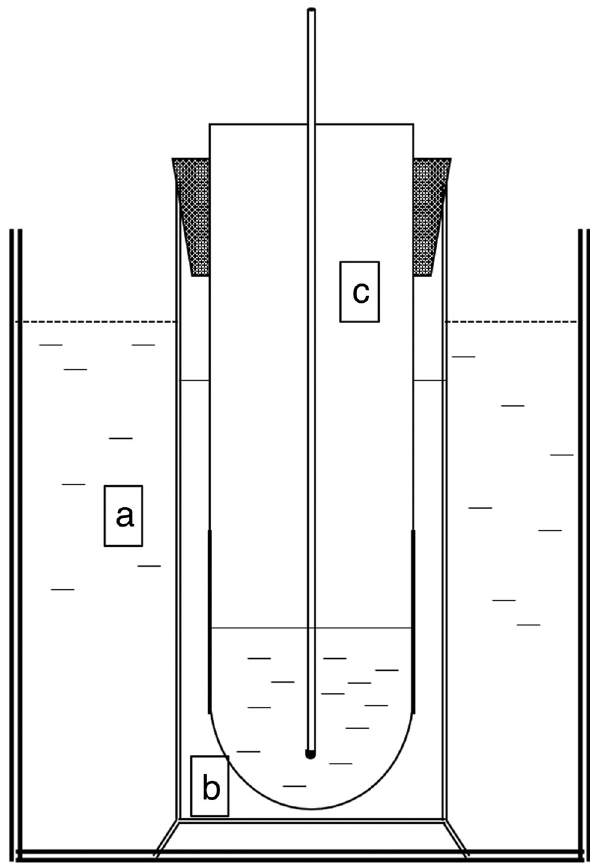
Figure 2: Apparatus used to determine the gelling temperature; ( a ) transparent glass beaker with water at 15°C, ( b ) bu ff er layer containing water at 35°C, and ( c ) inner testtubewithgelatin